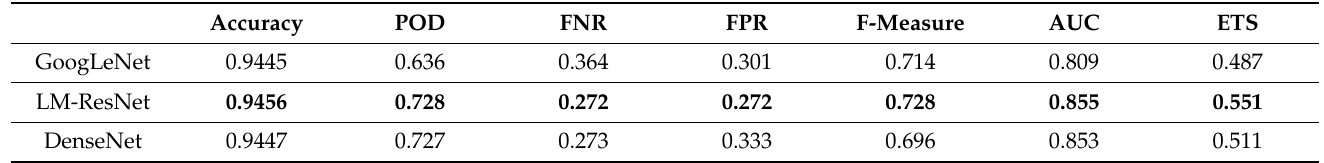
Figure 5. Results of training with cross entropy and focal loss by the LM-ResNet model. Table 1. The results are shown in different